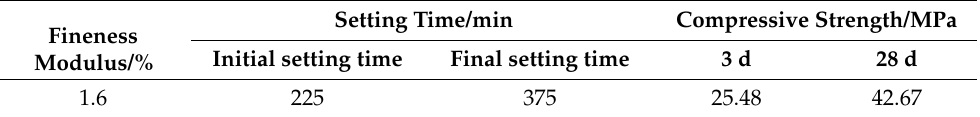
Table 2. Main performance index of cement.